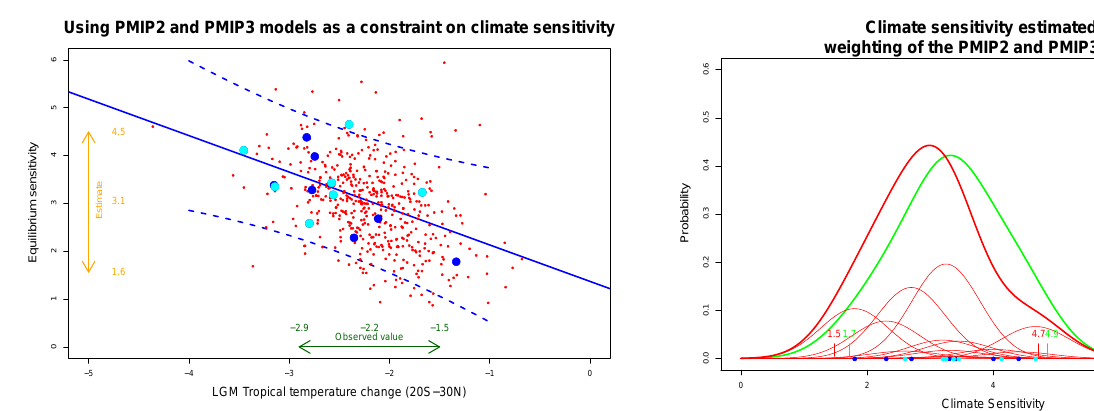
Fig. 6. Climate sensitivity estimated through weighting of the PMIP models. Blue and cyan dots represent PMIP2 and CMIP5 simu- lations respectively. Green curve shows prior distribution of cli- mate sensitivity (based on equal weighting of the models). Thick red curve shows posterior distribution, after weighting according to match to the LGM tropical temperature. Thin red curves show the individual models’ contributions to the posterior after weighting. Vertical bars indicate 5, 50 and 95